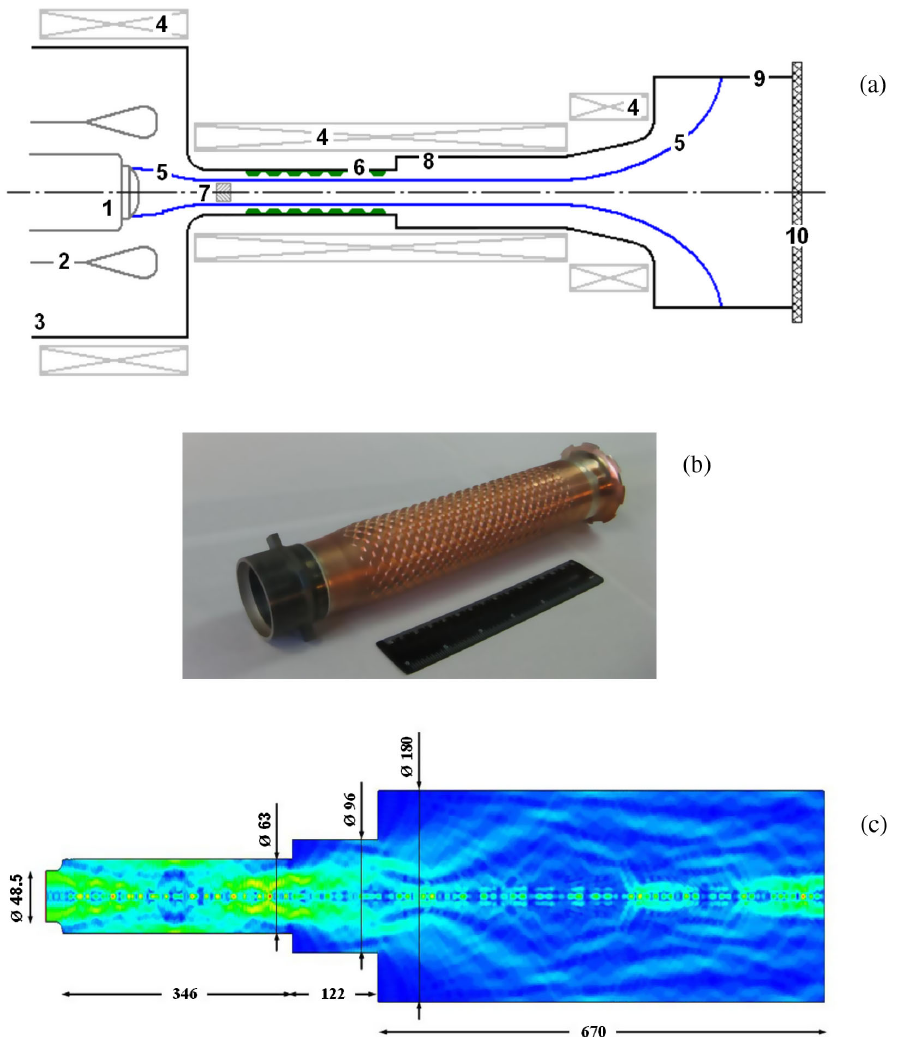
FIG. 7. (a) Scheme of experiments based on the SATURN accelerator: 1. electron beam cathode, 2. intermediate anode, 3. vacuum casing, 4. magnetic coils (solenoids), 5. electron beam trajectory, 6. slow-wave structure, 7. reflector for the radiated rf wave, 8. output section based on the Talbot effect, 9. electron beam collector, 10. output window. (b) Photograph of double periodic slow-wave structure (view outside). (c) Scheme and results of 3D simulations of the output SWO section based on the Talbot effect (geometrical sizes are given in